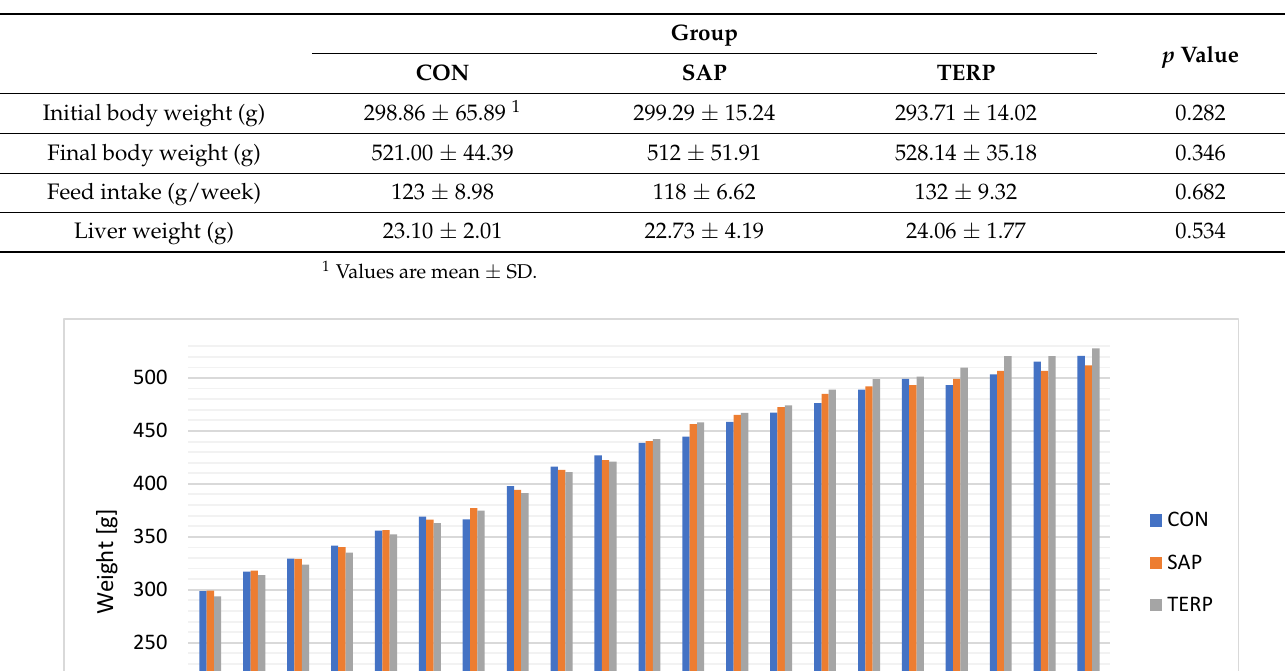
Table 4. Body weight, feed intake and liver weight.